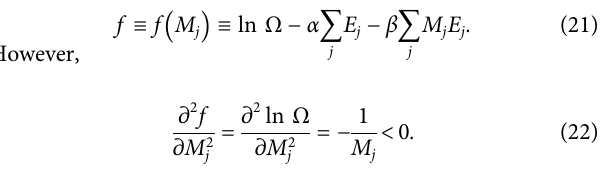
TABLE 4 | Cellular network statistical characteristics.